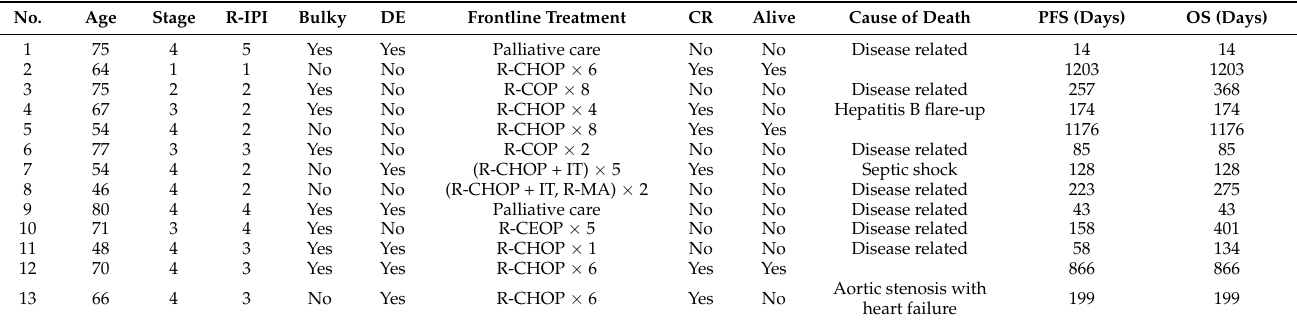
Table 3. Detailed profile of double hit (+) diffuse large B cell lymphoma